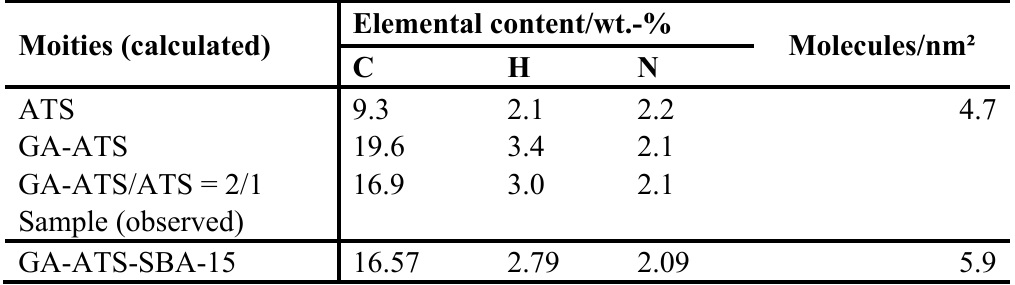
Table 2. Calculated elemental composition of the different moieties in comparison to the elemental analysis of GA-ATS-SBA-15.